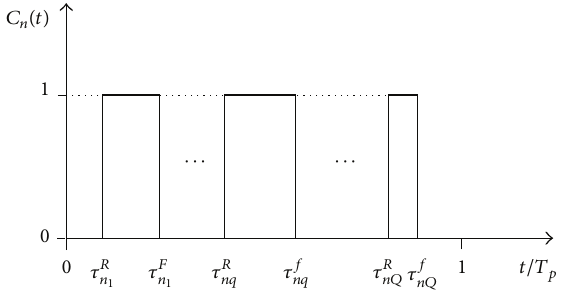
Figure 1: Example of split pulse controlling a RF